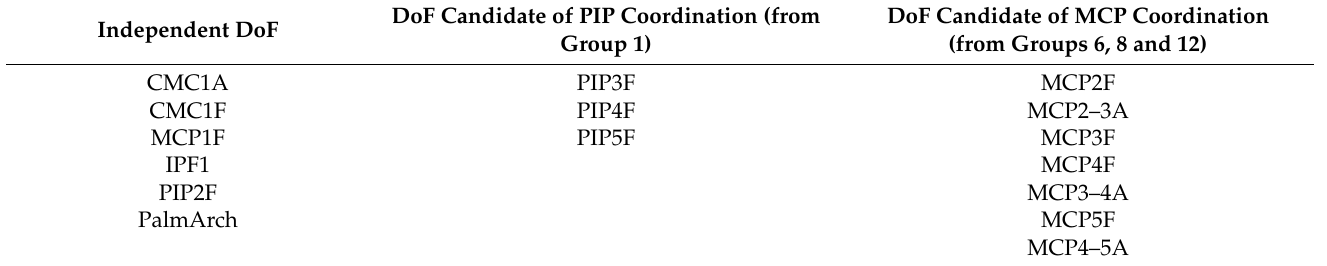
Table 2. Independent and candidate DoF for the estimation of physiological angles. F for flexion/extension and A for abduction/adduction movements. 1 to 5 for thumb to little digits.